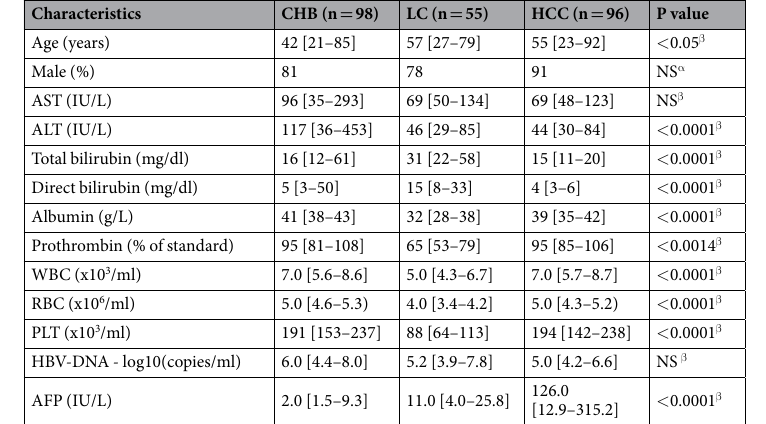
Table 1. Characteristics HBV patients segregated according to clinical presentation. CHB, chronic hepatitis B; LC, liver cirrhosis; HCC, hepatocellular carcinoma; RBC, red blood cells; WBC, white blood cells; PLT, platelets. AST and ALT, aspartate and alanine amino transferase; AFP, alpha-fetoprotein; IU, international unit; NR, normal range. Values given are medians with 25–75% percentiles. P values were calculated by chi-squared ( α ) or Kruskal-Wallis test ( β ).